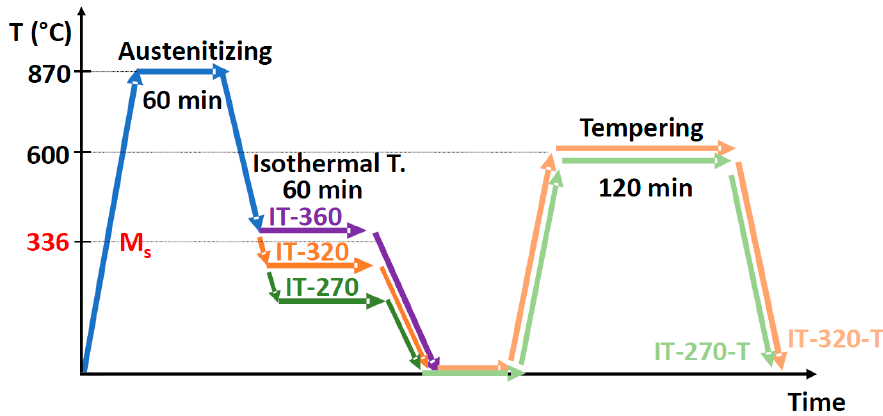
Figure 3. Graphical representation of the heat treatment conditions.